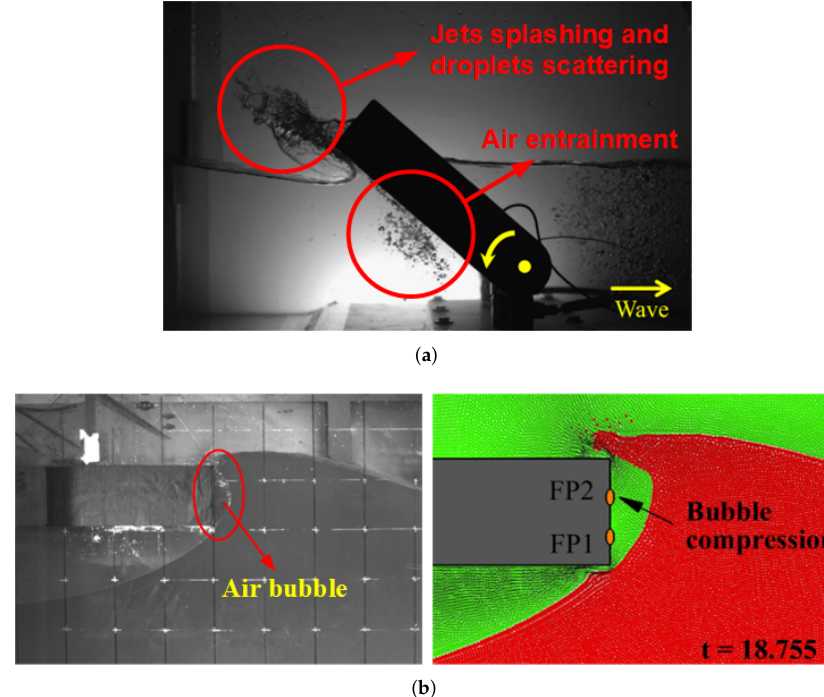
Figure 20. Typical air-entrainment phenomena in ocean engineering. ( a. ) OWSC slamming onto free-surface (adapted from [46]). ( b ) Freak wave slamming on structures (adapted from